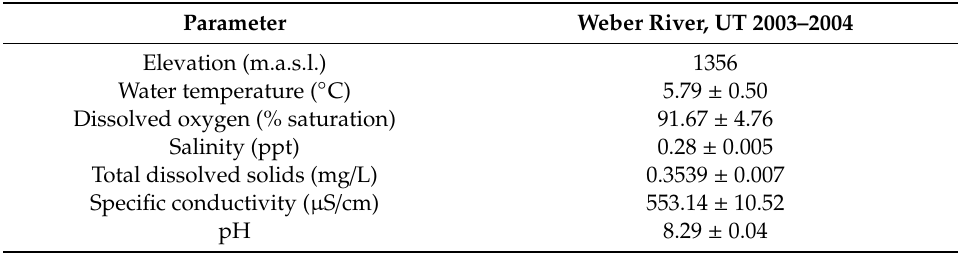
Table 1. Water quality and site measurements in the Weber River (UT, USA) for the study period from December 2003 to June 2004 ( n = 3). Values represent means ± 1 S.E.